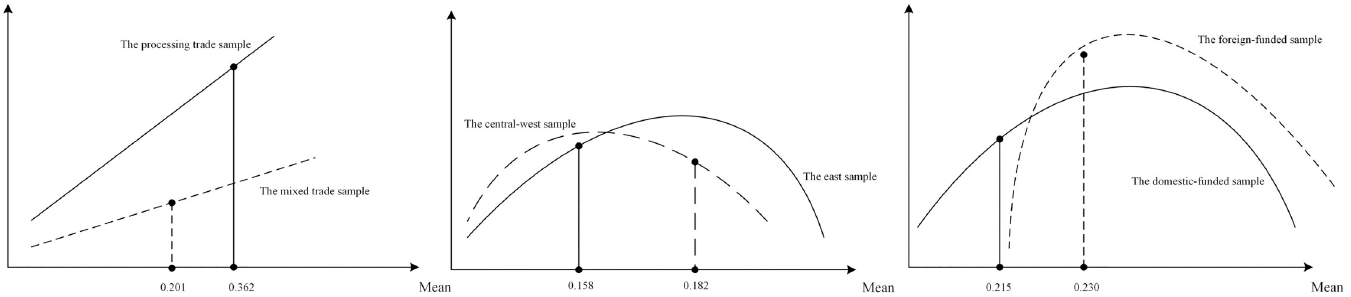
Fig 4. Visualization of heterogeneous regression